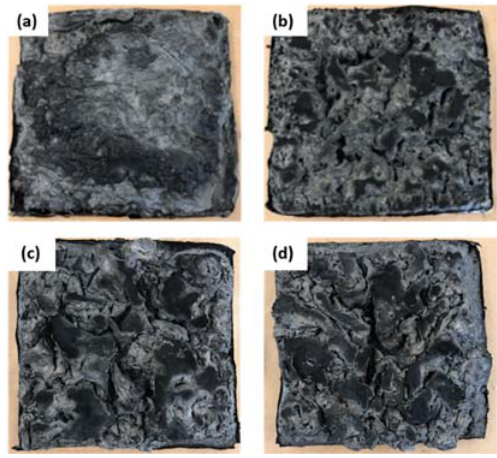
Figure 10. Char residues of ( a ) PLA / OS1 / APP10, ( b ) PLA / OS3 / APP10, ( c ) PLA / OS5 / APP10 and ( d ) PLA / OS7 / APP10 samples after cone calorimetry (PLA = polylactic acid; OS = oxidized starch; APP = ammonium polyphosphate)